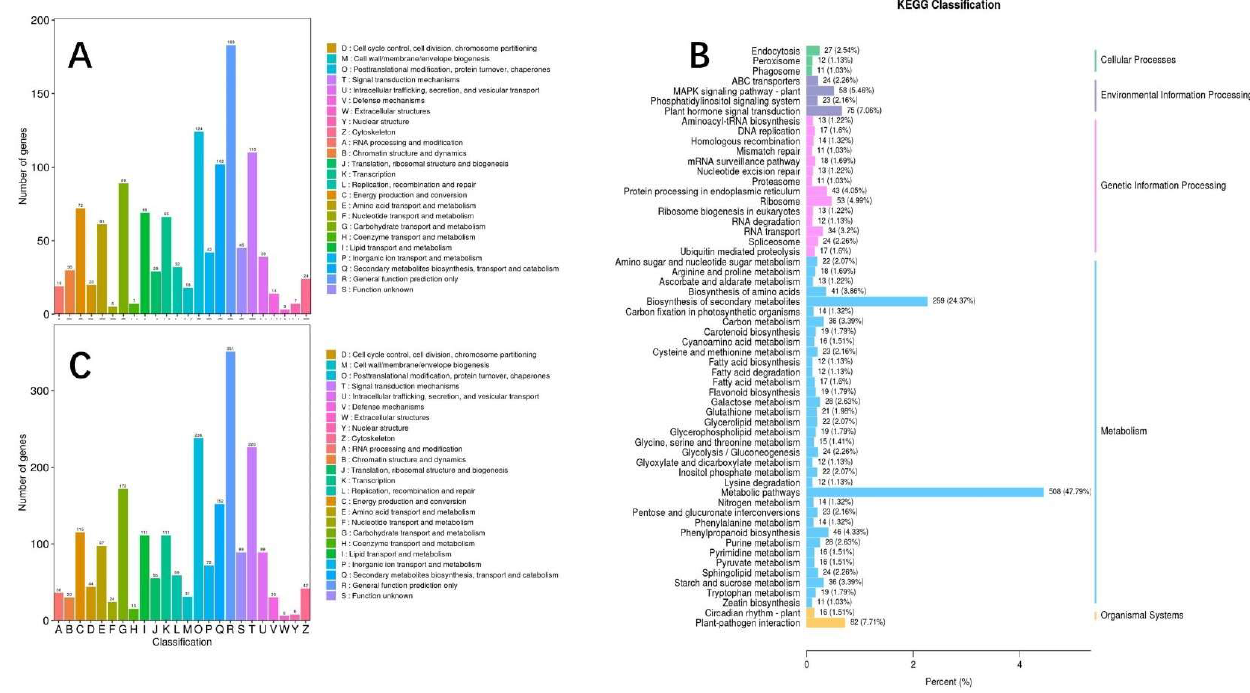
Figure 9. The KEGG classification of differentially expressed genes: between No drought & Seedling stage ( A ), between Seedling & Flowering stage ( B ), and between No drought & Flowering stage ( C